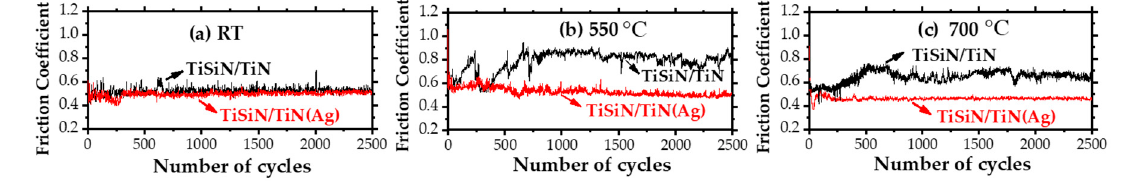
Figure 2. Friction coefficient (COF) of the reference and Ag-alloyed coatings as a function of the number of cycles tested against TiAl6V4 balls at ( a ) RT, ( b ) 550 °C and ( c ) 700 °C.